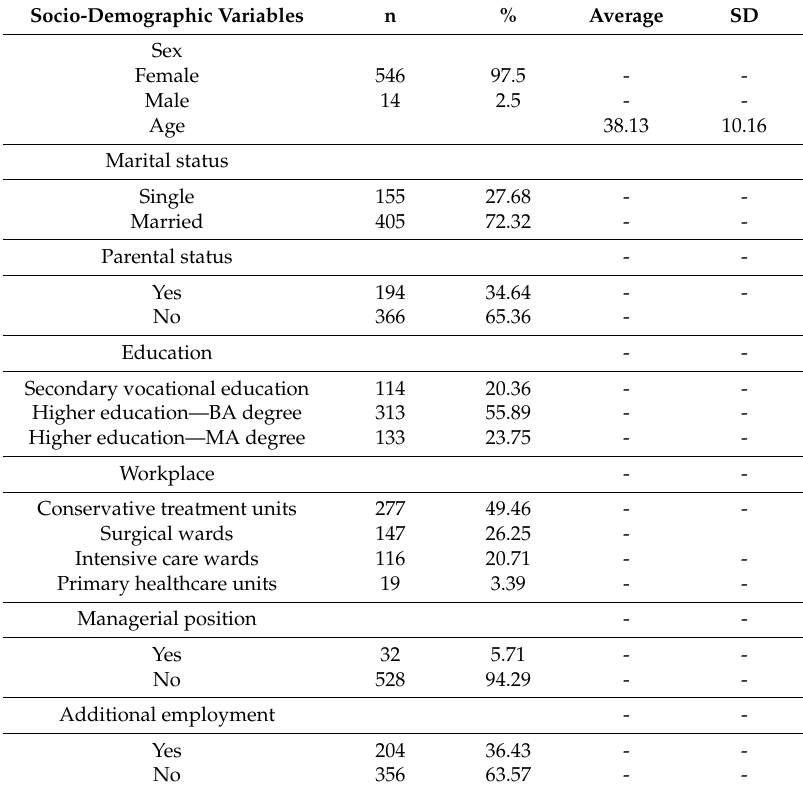
Table 1. Socio-demographic characteristics of the examined group of